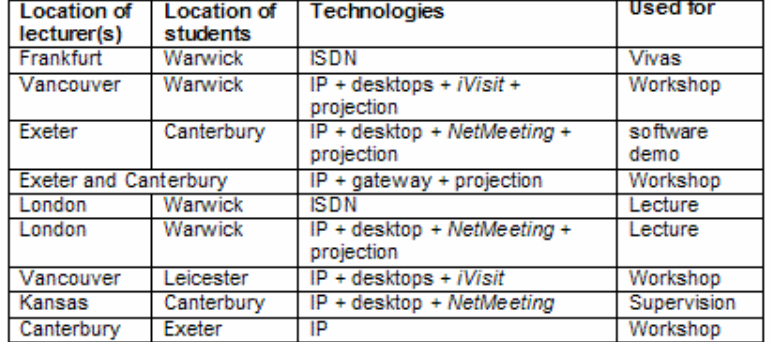
Table 1 . List of Videoconferences Conducted as Part of the ANNIE Project